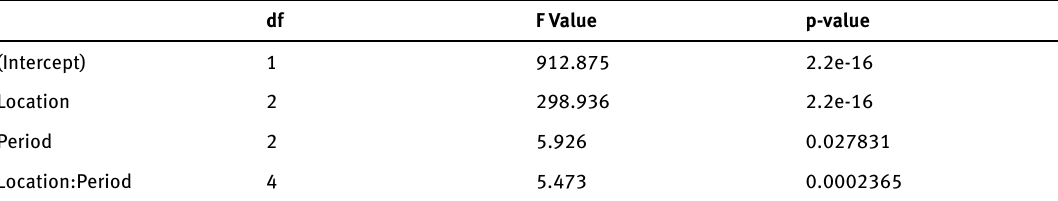
Table 4. ANOVA Result for the Response Variable: Distance of Churches in Use to Settlements.